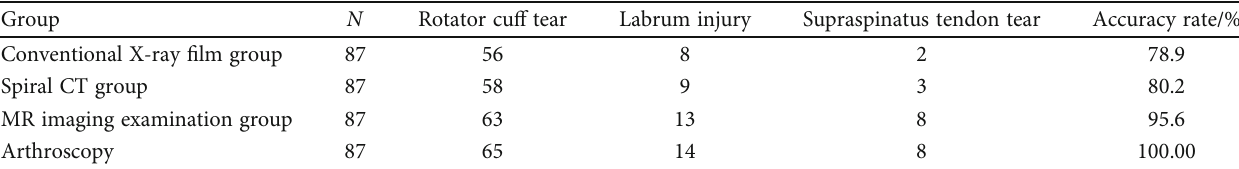
Figure 4: The proportion of shoulder joint injuries detected in the three Table 3: Diagnosis of shoulder joint injury by three methods.